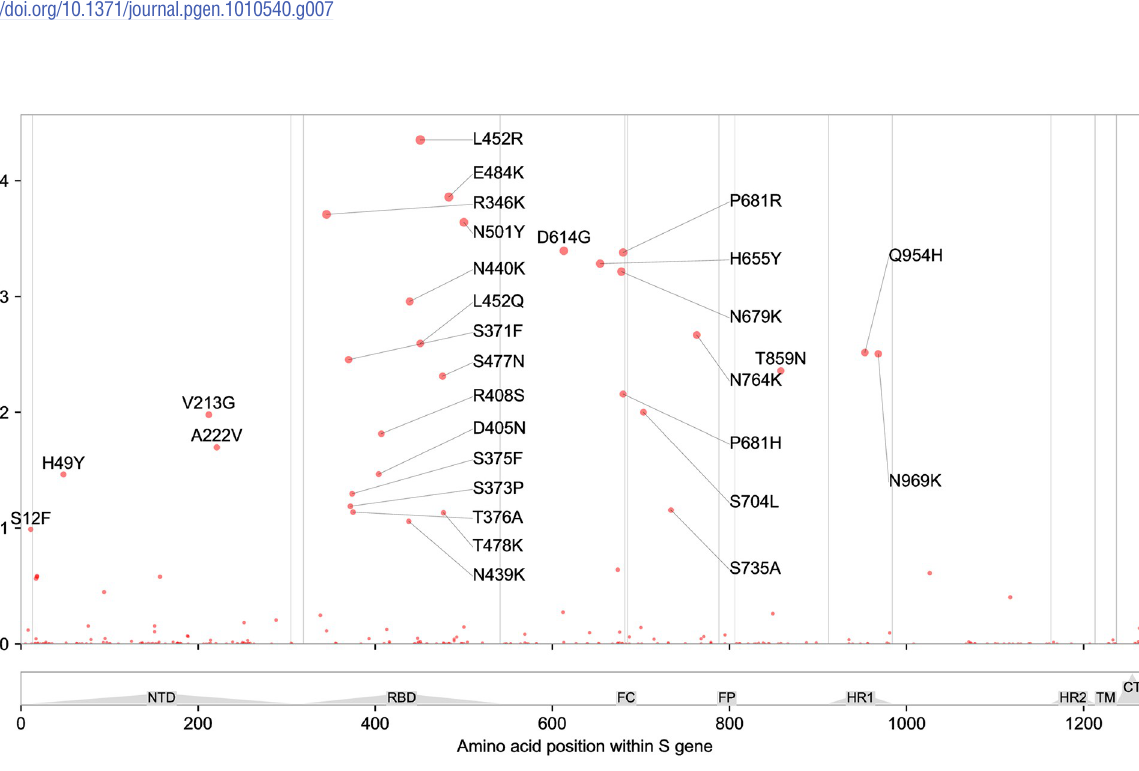
Fig 8. S-gene Manhattan plot. View of the 1237 amino acids of the S protein, annotated by structure [47]; many top-scoring mutations are located in the N-terminal domain (NTD), receptor-binding domain (RBD), and furin cleavage (FC) site. Regions containing the fusion peptide (FP), heptad repeat (HR) 1 and 2, transmembrane domain (TM), and C-terminal domain (CTD) are also annotated.